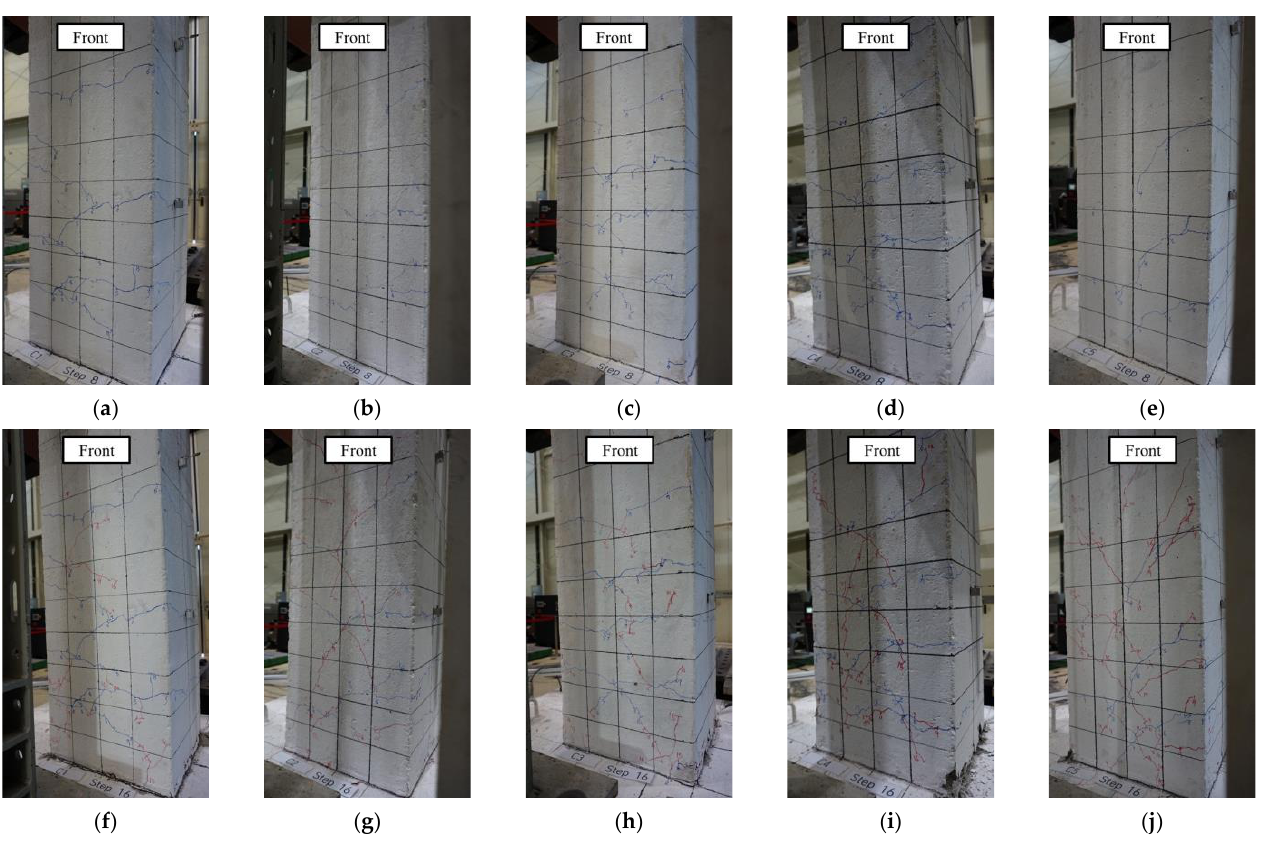
Figure 5. Crack pattern and damage state observed in the column before failure: ( a ) – ( e ) Step 8 (in the order of C1, C2, C3, C4, and C5); ( f ) – ( j ) Step 16 (in the order of C1, C2, C3, C4, and C5).